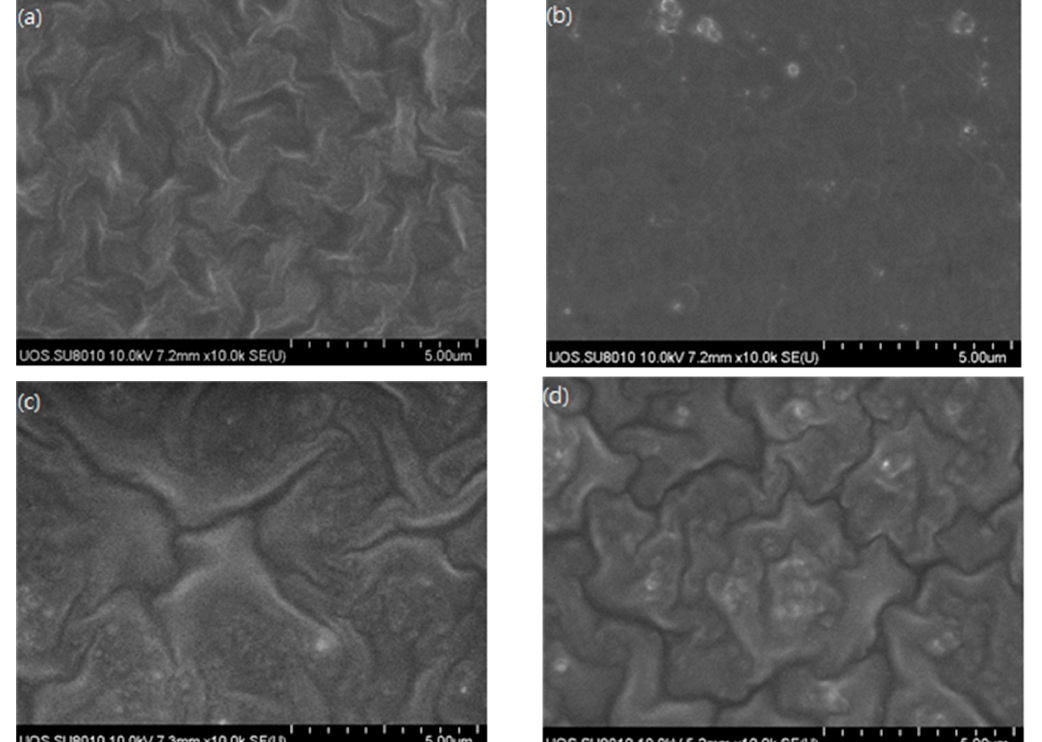
Figure 11. FE ‐ SEM images of the surface of ( a ) Pebax ‐ 2533/ZIF ‐ 7 0 wt%, ( b ) 5 wt%, ( c ) 25 wt%, and ( d ) 35 wt% composite Figure 11. FE-SEM images of the surface of ( a ) Pebax-2533/ZIF-7 0 wt%, ( b ) 5 wt%, ( c ) 25 wt%, and ( d ) 35 wt% membranes. composite